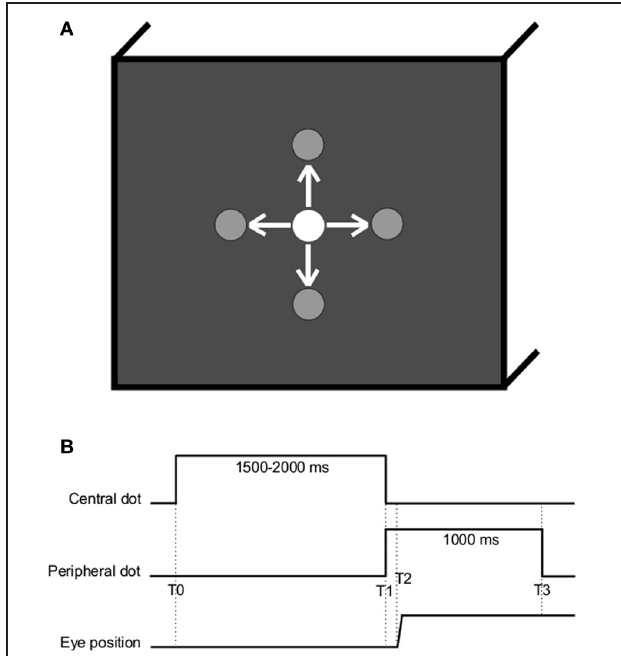
FIGURE 1 | (A) Spatial arrangement. The white dot is here represented at the center but could be located at one of the other peripheral locations (gray), at ± 10 ◦ horizontally or vertically. Arrows represent the possible saccade stimulation. (B) Temporal arrangement (T0, central dot turns on; T1, central dot cuts off and peripheral dot turns on; T2–T1, latency of ocular response; T3, peripheral dot cuts